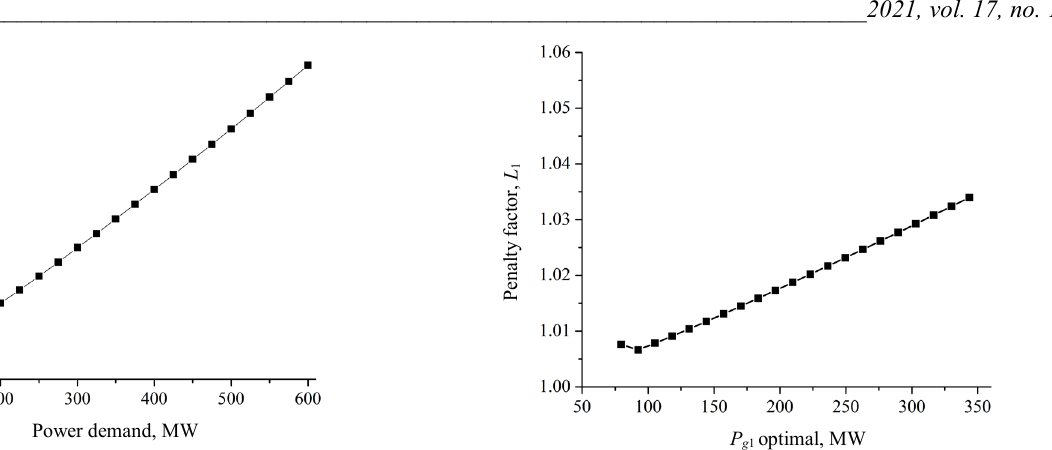
Fig. 8. Penalty factor L 1 vs P g 1, optimal.